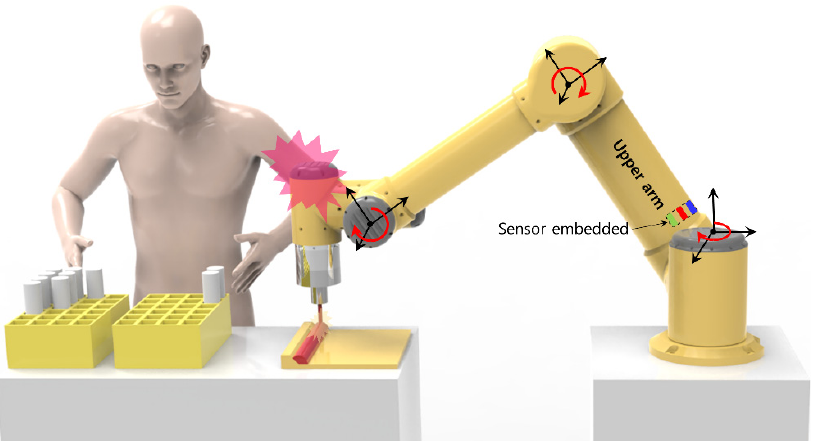
Figure 1. A robot arm link embedded with a three-axis sensor detects a collision with an operator.